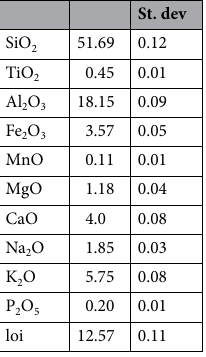
Table 1. Chemical composition of TRS. The data shown are the result of the average of 15 analyses. Loi loss on ignition.